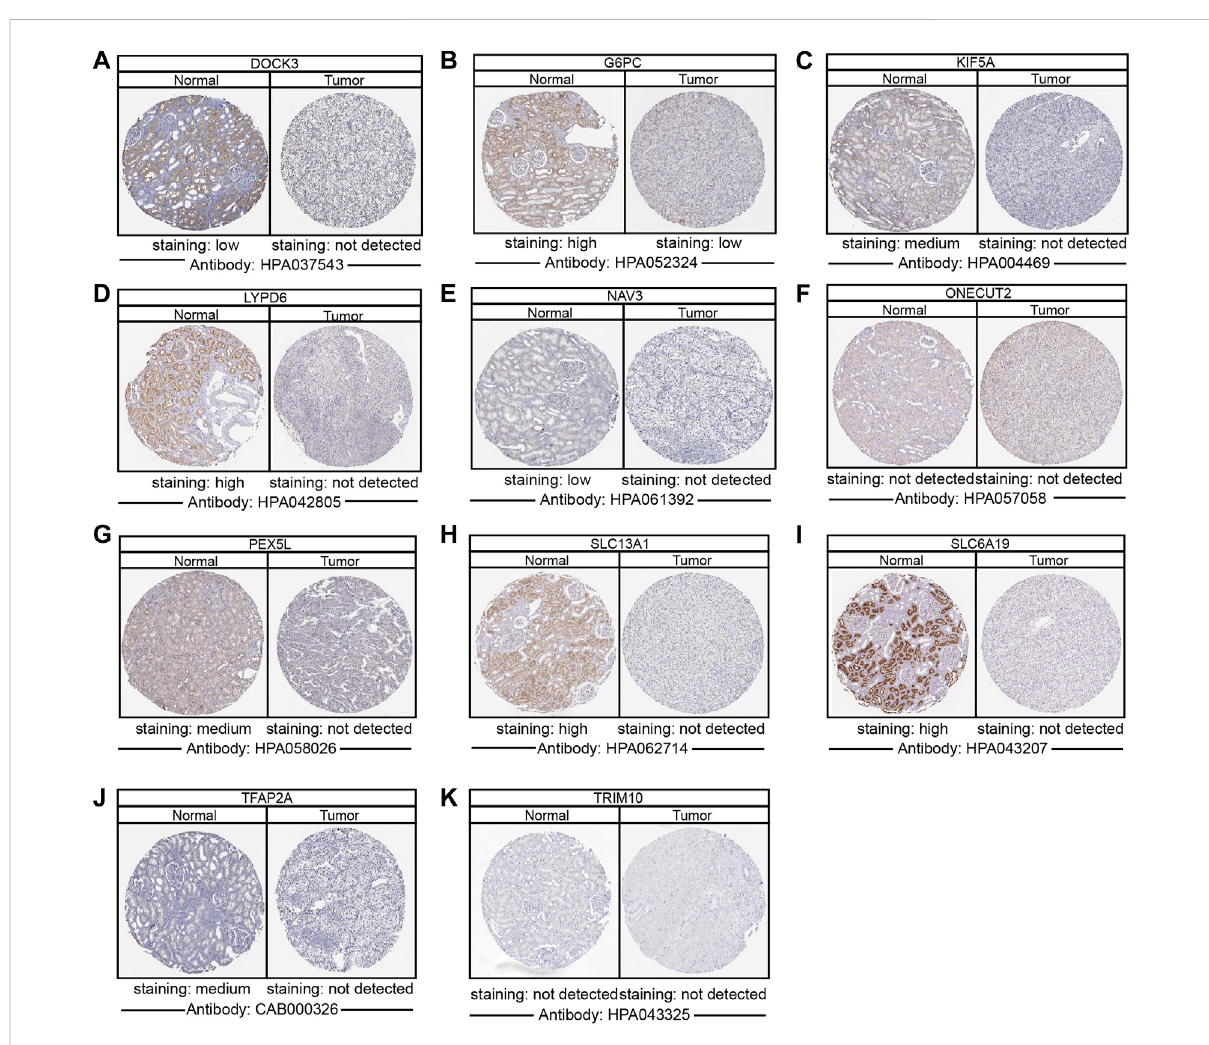
FIGURE 4 Validation of the expression of DEipr-miRNAs-regulated ipr-DEGs. (A – K) The protein expressions of indicated DEipr-miRNAs-regulated ipr- DEGs in ccRCC tumor and normal tissues using clinical specimens from the Human Protein Pro fi